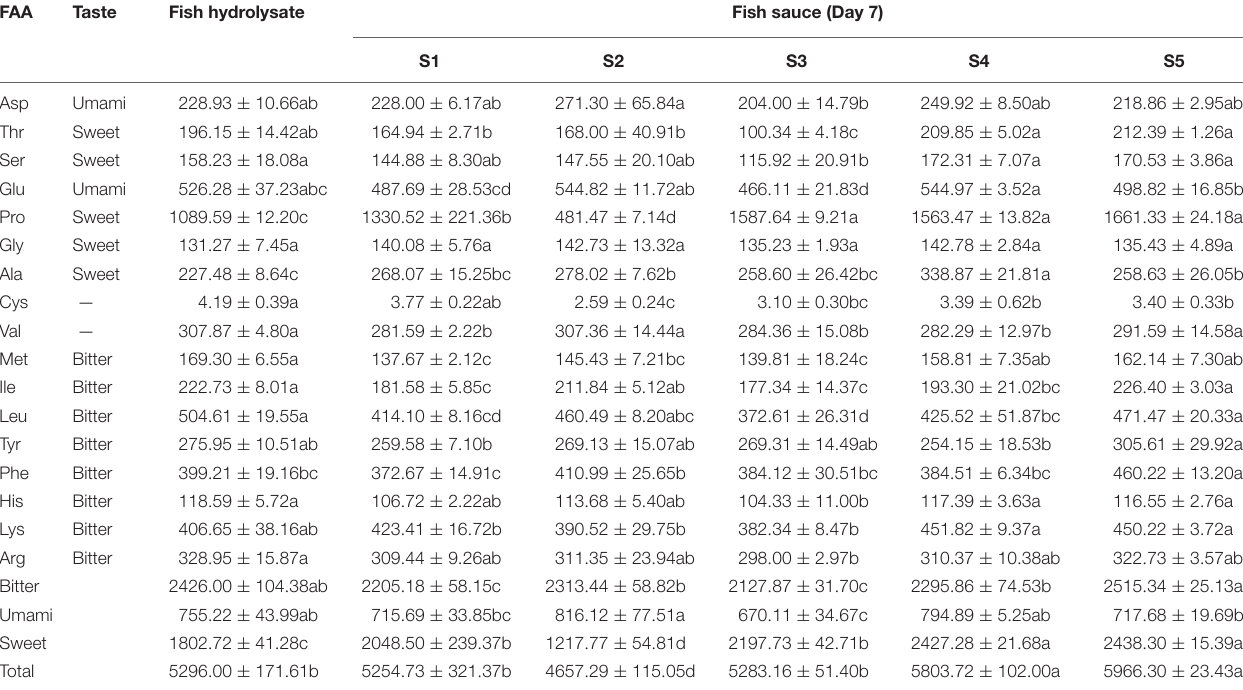
TABLE 1 | Free amino acids (FAA) in fish sauce fermented with different yeasts